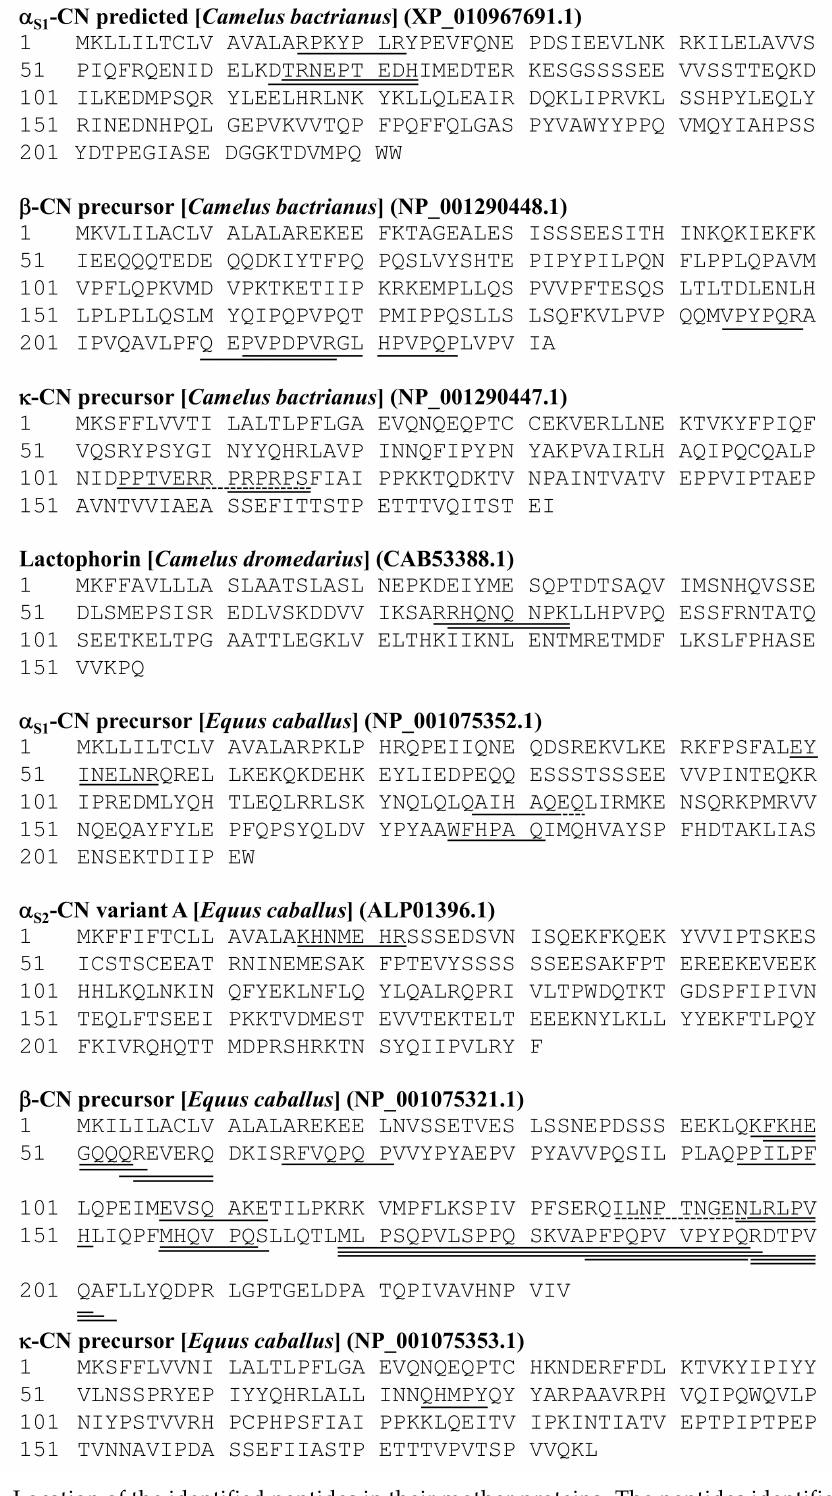
Figure 3. Location of the identified peptides in their mother proteins. The peptides identified in this study are indicated by underlines. The NCBI reference numbers of the mother proteins are indicated in the parentheses. The numbers present at the left-most of the column indicate the number of amino acid residues that started from the N-terminal methionine of the precursors. Dotted lines indicate sequence inconsistency between the identified peptide and the mother protein used as reference, probably due to the presence of genetic